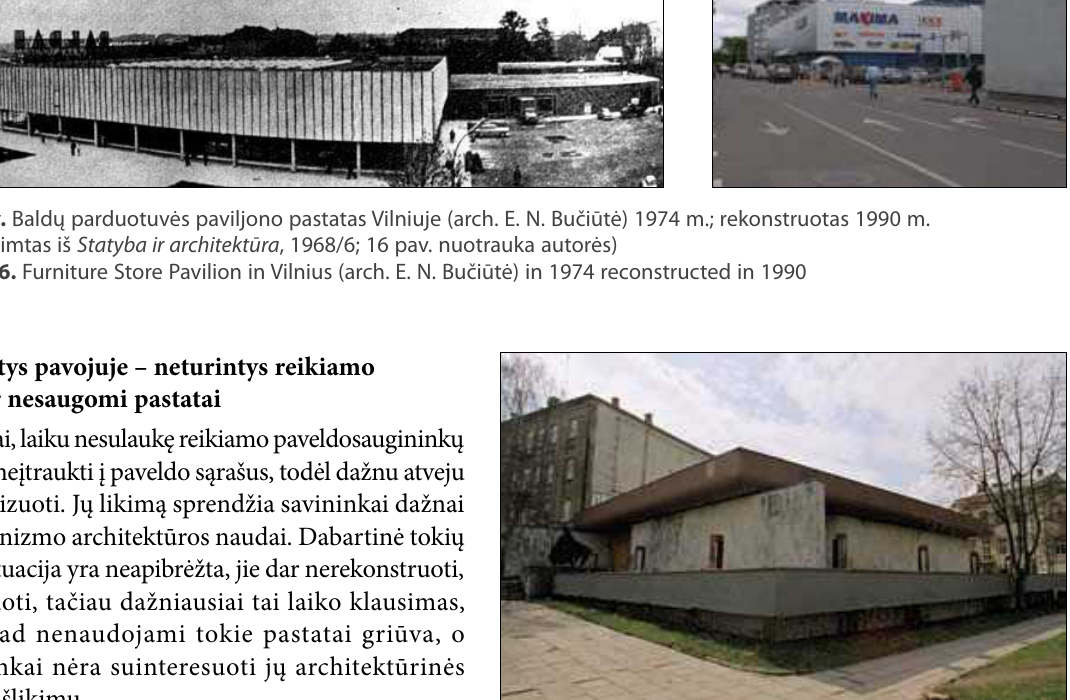
Fig. 17. beer r­estau­rant “tau­ro ragas“ (arch. e. Gūzas, a­. Mačiu­lis) bu­ilt in